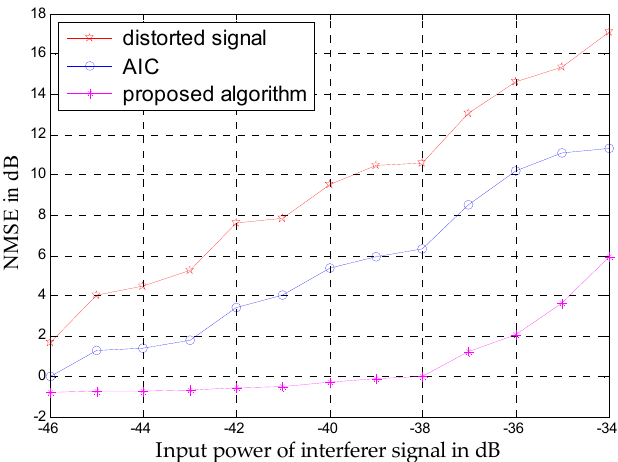
Figure 12. NMSEs of the weak 16-QAM at different input power levels for the unmitigated signal and the outputs of both AIC and the proposed algorithm.